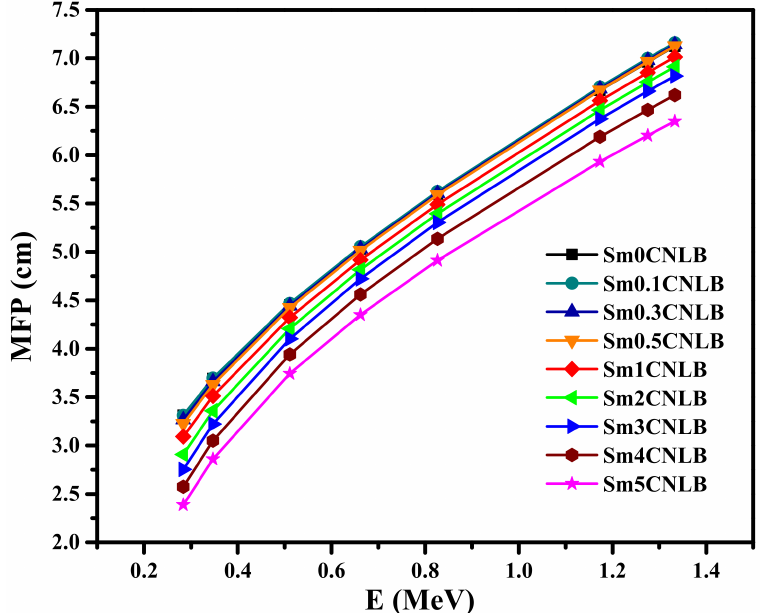
Figure 9. The mean free path (MFP) of the Sm x CNLB